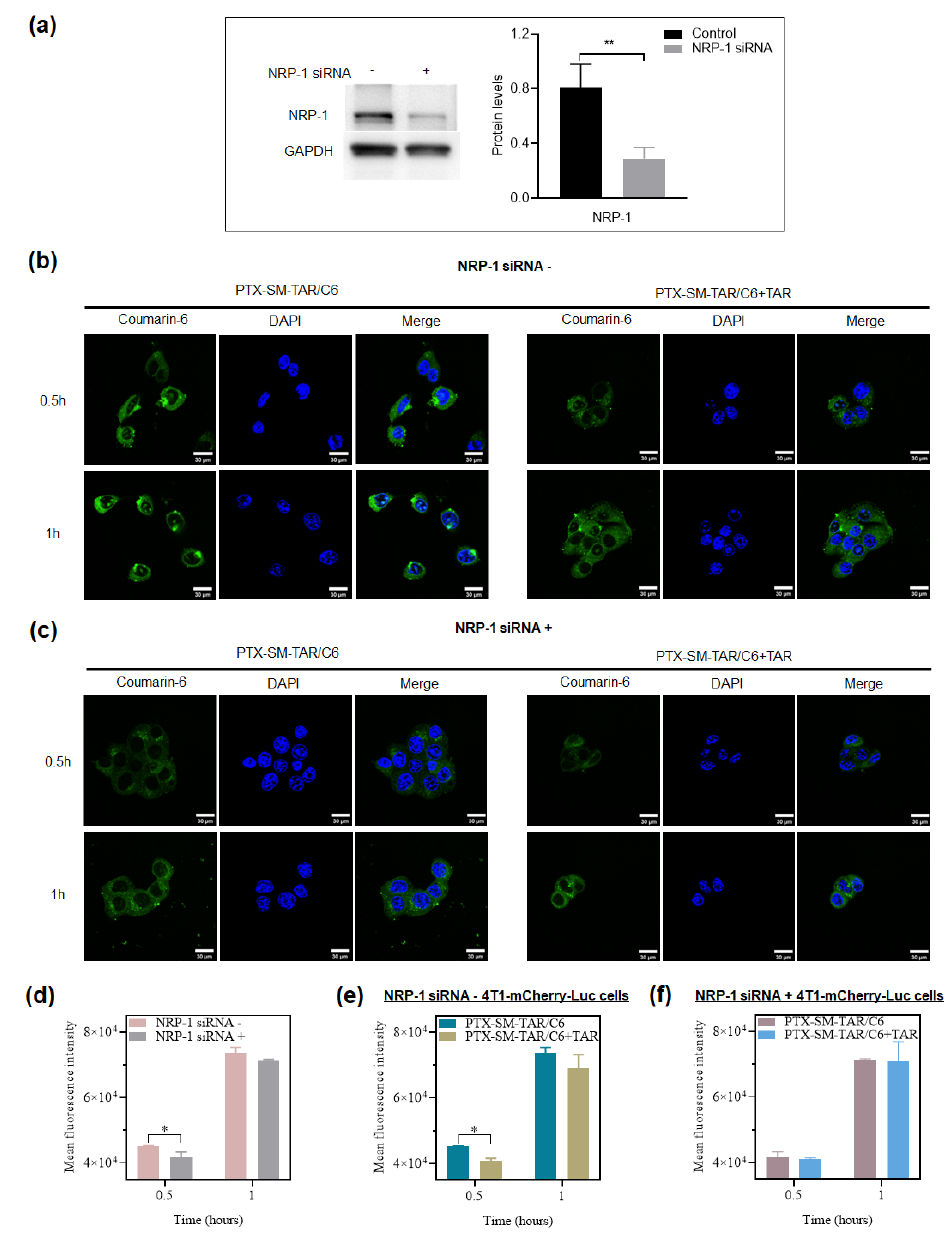
Figure 4. The targeting properties of PTX-SM-TAR NPs. ( a ) Western blot analysis of NRP-1 expression in NRP-1 siRNA untreated and treated 4T1-mCherry-Luc cells (mean ± SEM, n = 3, ** indicates p < 0.01). ( b ) Confocal images of untreated 4T1-mCherry-Luc cells (NRP-1 siRNA-, NRP1 high expressed). The cell nuclei were stained with DAPI (blue), and the PTX-SM-TAR NPs were dyed with coumarin-6 (green). The scale bar is 30 µ m. ( c ) Confocal images of NRP-1 siRNA treated 4T1-mCherry-Luc cells (NRP-1 siRNA+, NRP1 low expressed). The cell nuclei were stained with DAPI (blue), and the PTX-SM-TAR NPs were dyed with coumarin-6 (green). The scale bar is 30 µ m. ( d ) Flow cytometry analysis of NRP-1 siRNA untreated and treated 4T1-mCherry-Luc cells. (mean ± SEM, n = 3, * indicates p < 0.05). ( e ) Flow cytometry analysis of wild 4T1-mCherry-Luc cells treated with PTX-SM-TAR/C6 NPs and PTX-SM-TAR/C6 NPs plus TAR peptide groups (mean ± SEM, n = 3, * indicates p < 0.05). ( f ) Flow cytometry analysis of NRP-1 siRNA treated 4T1-mCherry-Luc cells treated with PTX-SM-TAR/C6 NPs and PTX-SM-TAR/C6 NPs plus TAR peptide groups ( n = 3).